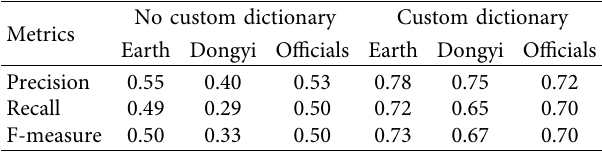
Table 2: Word-segmentation results of sample texts with the THULAC NLP